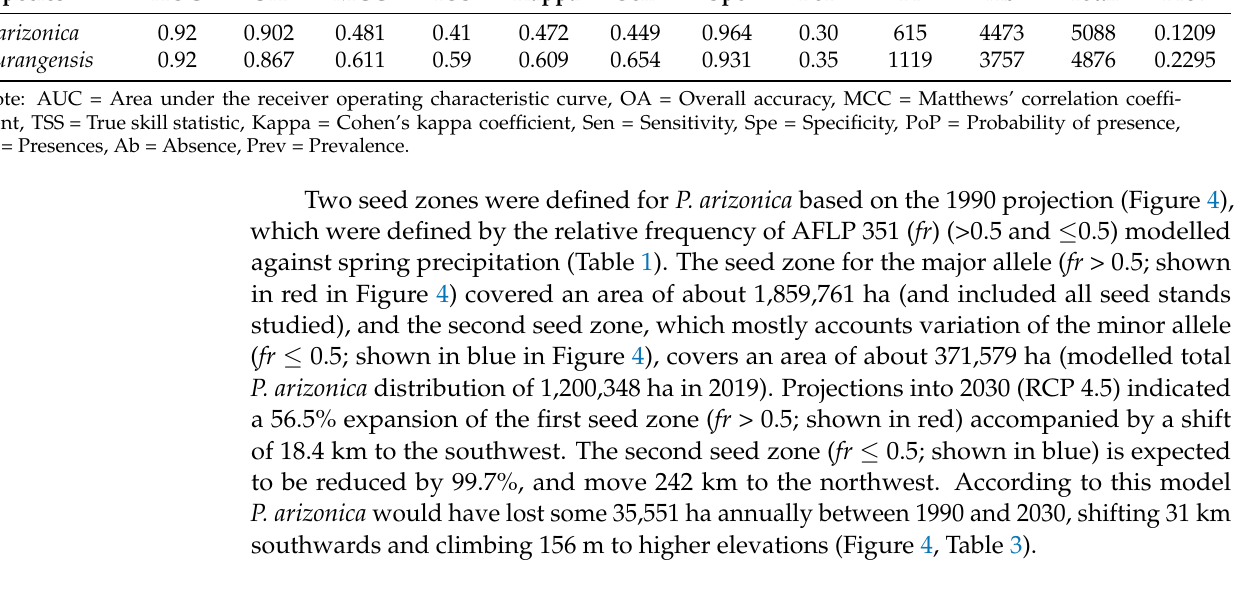
Table 2. Model fit metrics for the Pinus distribution models (SDM) estimated with Random Forest. Model fit was assessed both on training data used to fit the model and on the withheld test data used for model validation (5-fold).